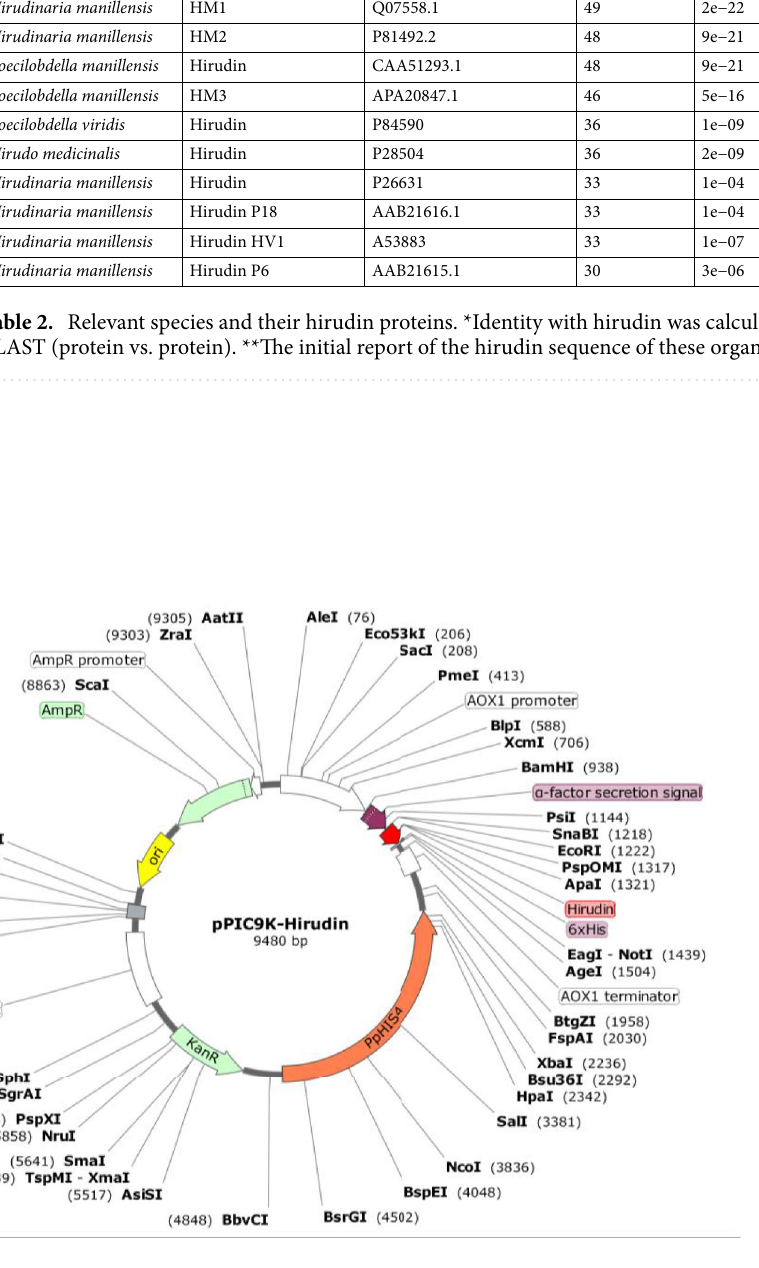
MRFPSIFTAVLFAASSALAAPVNTTTEDETAQIPAEAVIGYSDLEGDFDVAVLPFSNSTNNGLLFINTTIASIAAKEEG VSLEKREAEA YVEFQHFKDCSDSNPTPCLCENSNLCAFGNTCDLGPPKKCIIKVSPPPTSEKEKNNNKGSKSDY DYY HHHHHH .. Figure 8. A schematic map of the recombinant plasmid pPIC9K-hirudin. (The target gene is marked in